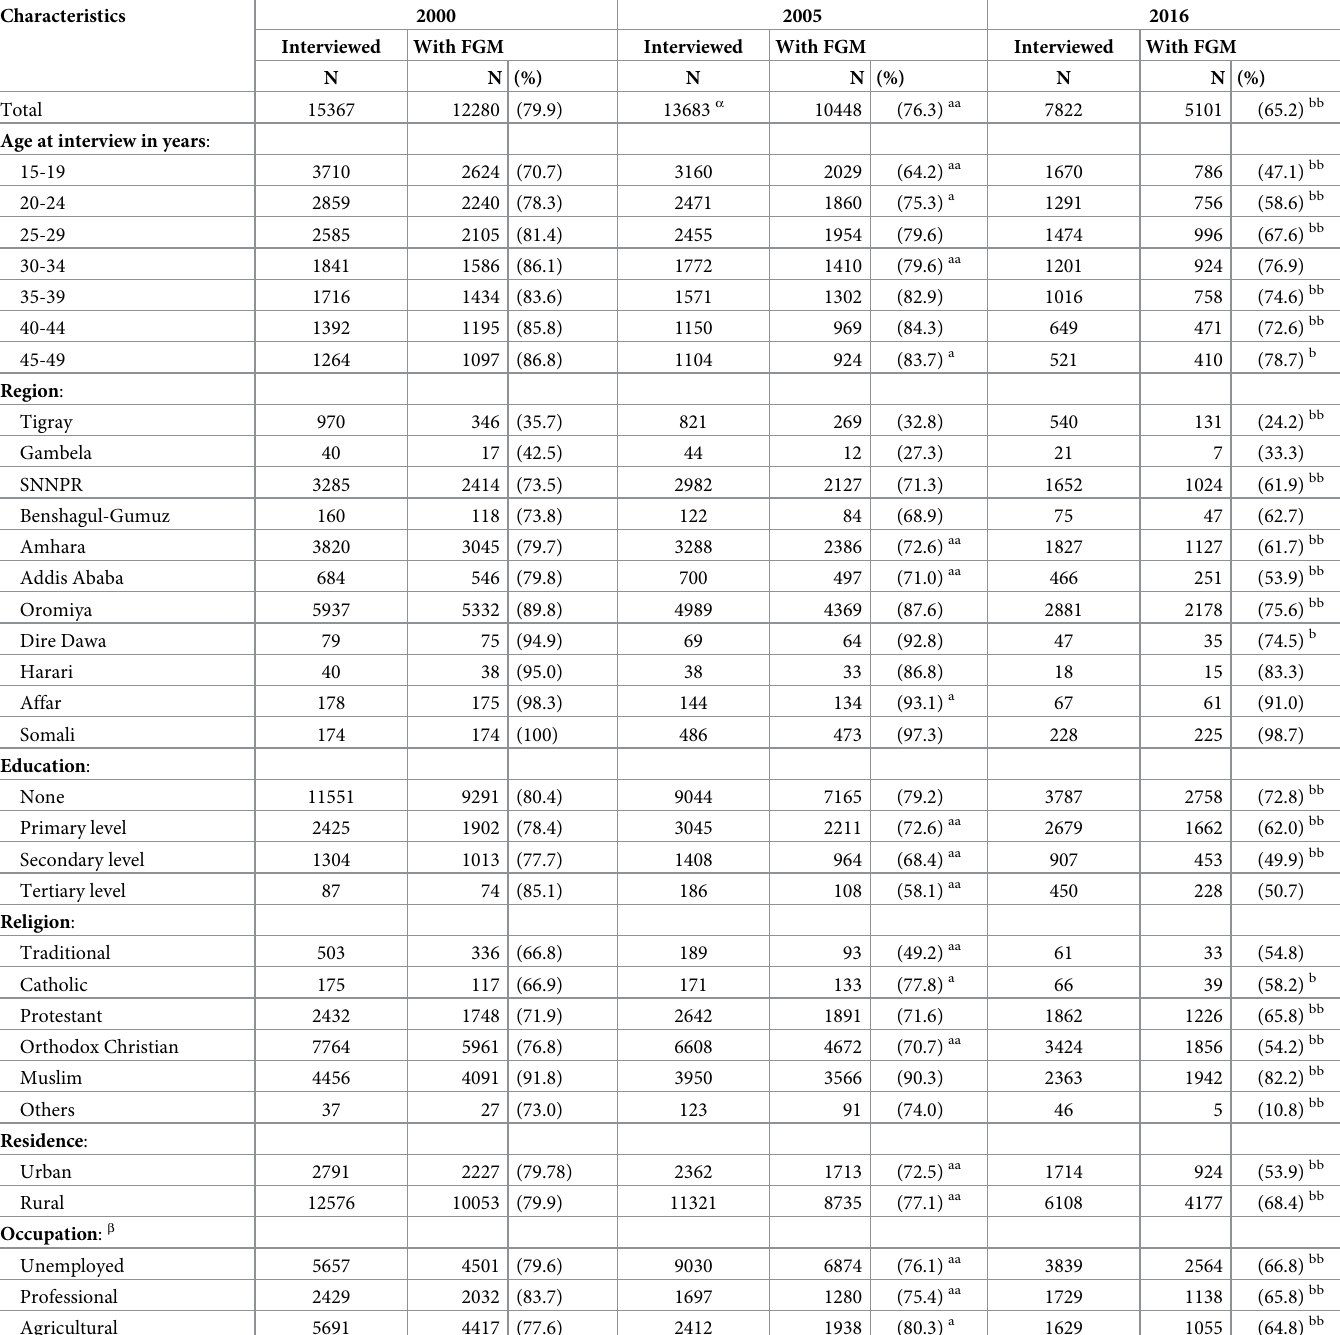
Table 4. Socio-demographic factors associated with female genital mutilation (FGM) in Ethiopia: 2000, 2005 and 2016.